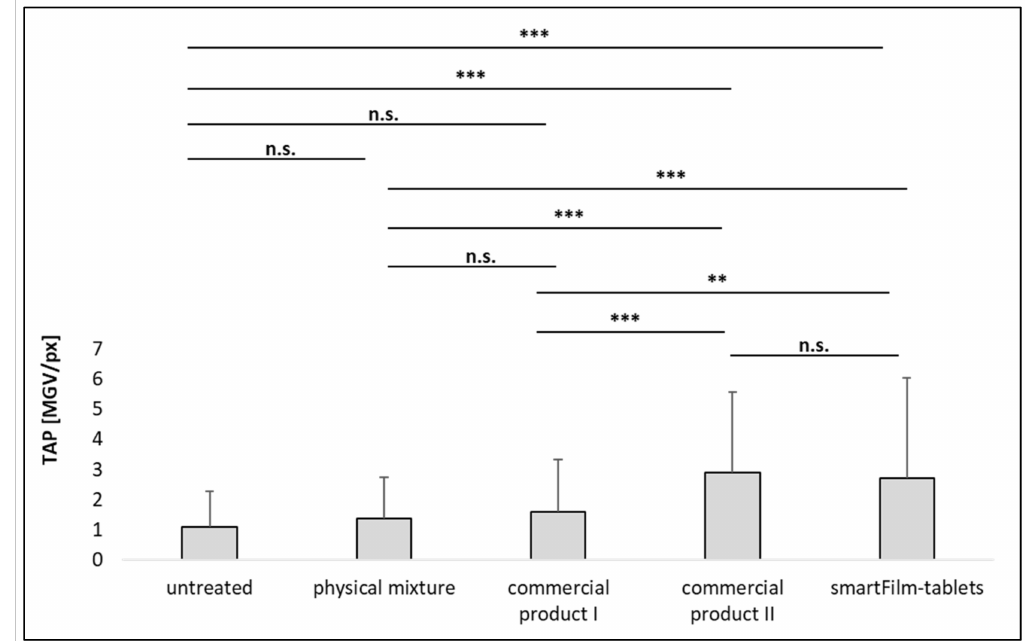
Figure 7. Permeated amount of curcumin from different formulations. The total amount permeated (TAP, MGV/px) is a semi-quantitative parameter that surrogates the intestinal permeability, i.e., oral